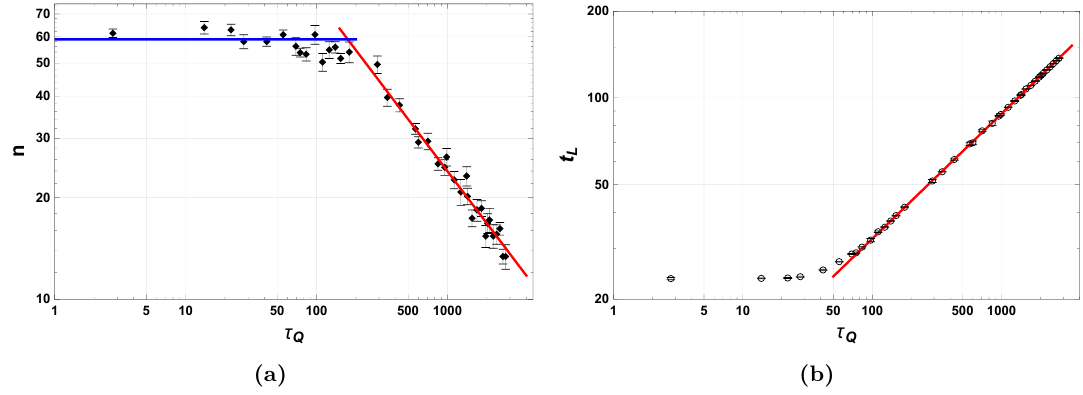
Figure 3. Universal scalings of vortex number density and lag time versus quench time. (a) Relation between vortex number density n and quench time τ Q . Solid diamonds are numerical data while blue and red lines are from the best fit. Error bars denote the standard deviations. Scalings in slow quench (large τ Q ) satisfy KZM prediction, n ∝ ˆ ξ − 2 = ξ − 2 vortex number in fast quenches (small τ Q ) is almost constant, independent of τ Q . These quenches are essentially “impulse” — they start within the impulse interval ( − ˆ t, +ˆ t ) . (b) Relations between the lag time t L and τ Q . Circles are the numerical data and the error bars are small compared to the size of circles. Red fitted line shows a good agreement with the KZM prediction, t L ’ τ the slow quench